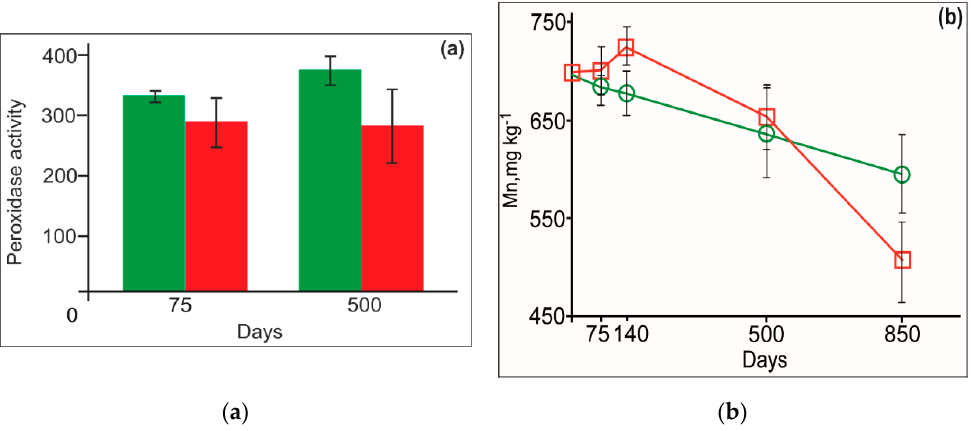
Figure 6. Peroxidase activity ( a ) (mg of purpurogallin per 100 g of soil in 30 min) in litterbags on the sampling dates. Data in the figure denote the mean sample combined from six individual litterbags. Dynamics of Mn concentration ( b ) during the decomposition experiment. Error bars represent ±SE ( n = 6).